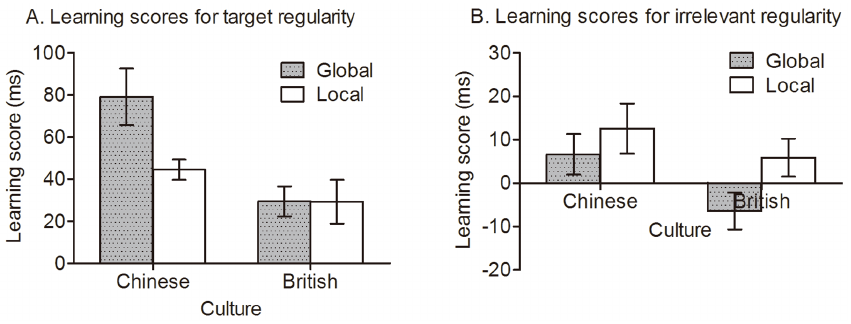
Figure 5. Learning scores of target and irrelevant regularities in each group. Error bars depict standard errors.